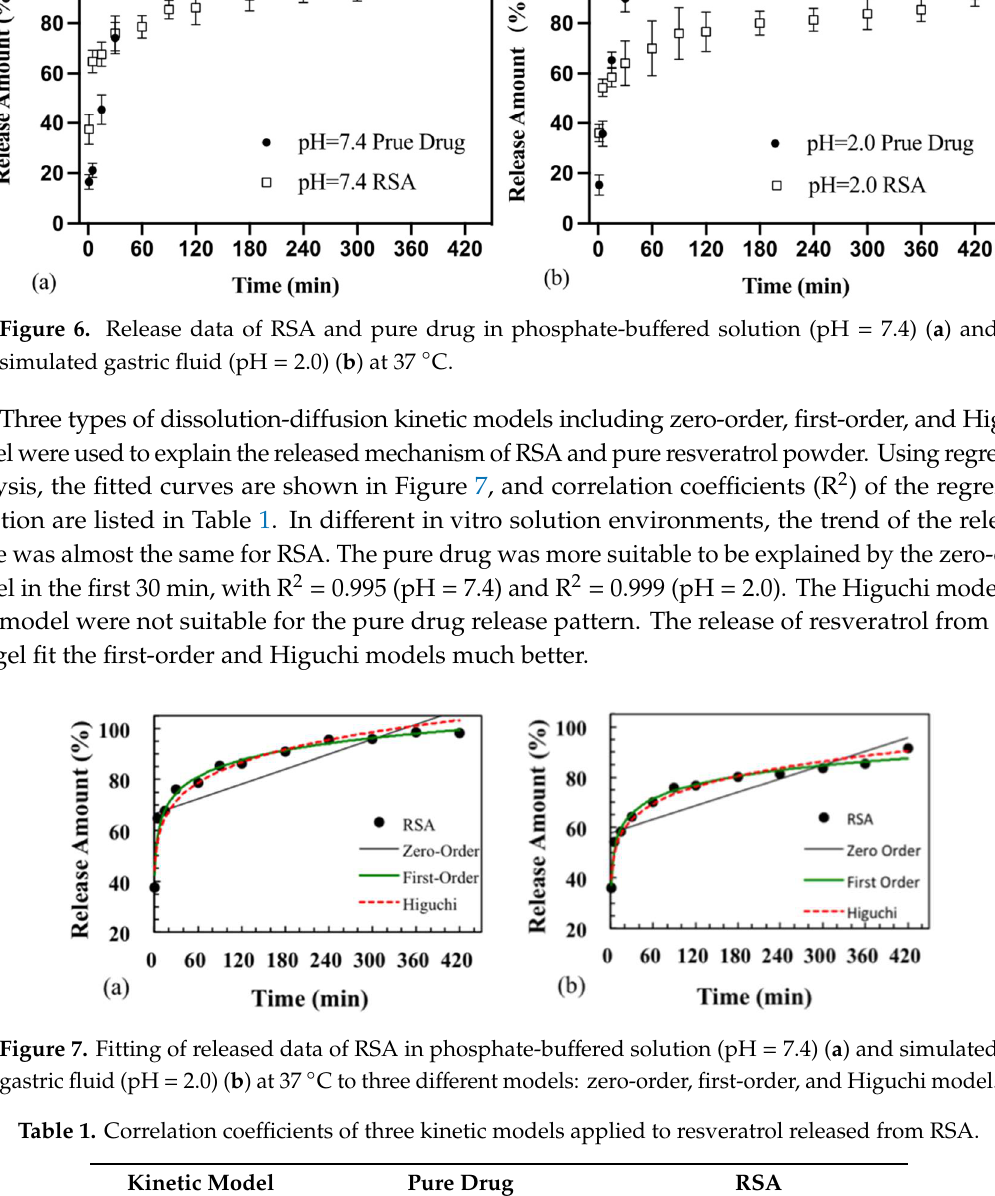
Figure 6. Release data of RSA and pure drug in phosphate-buffered solution (pH = 7.4) ( a ) and simulated gastric fluid (pH = 2.0) ( b ) at 37 °C.